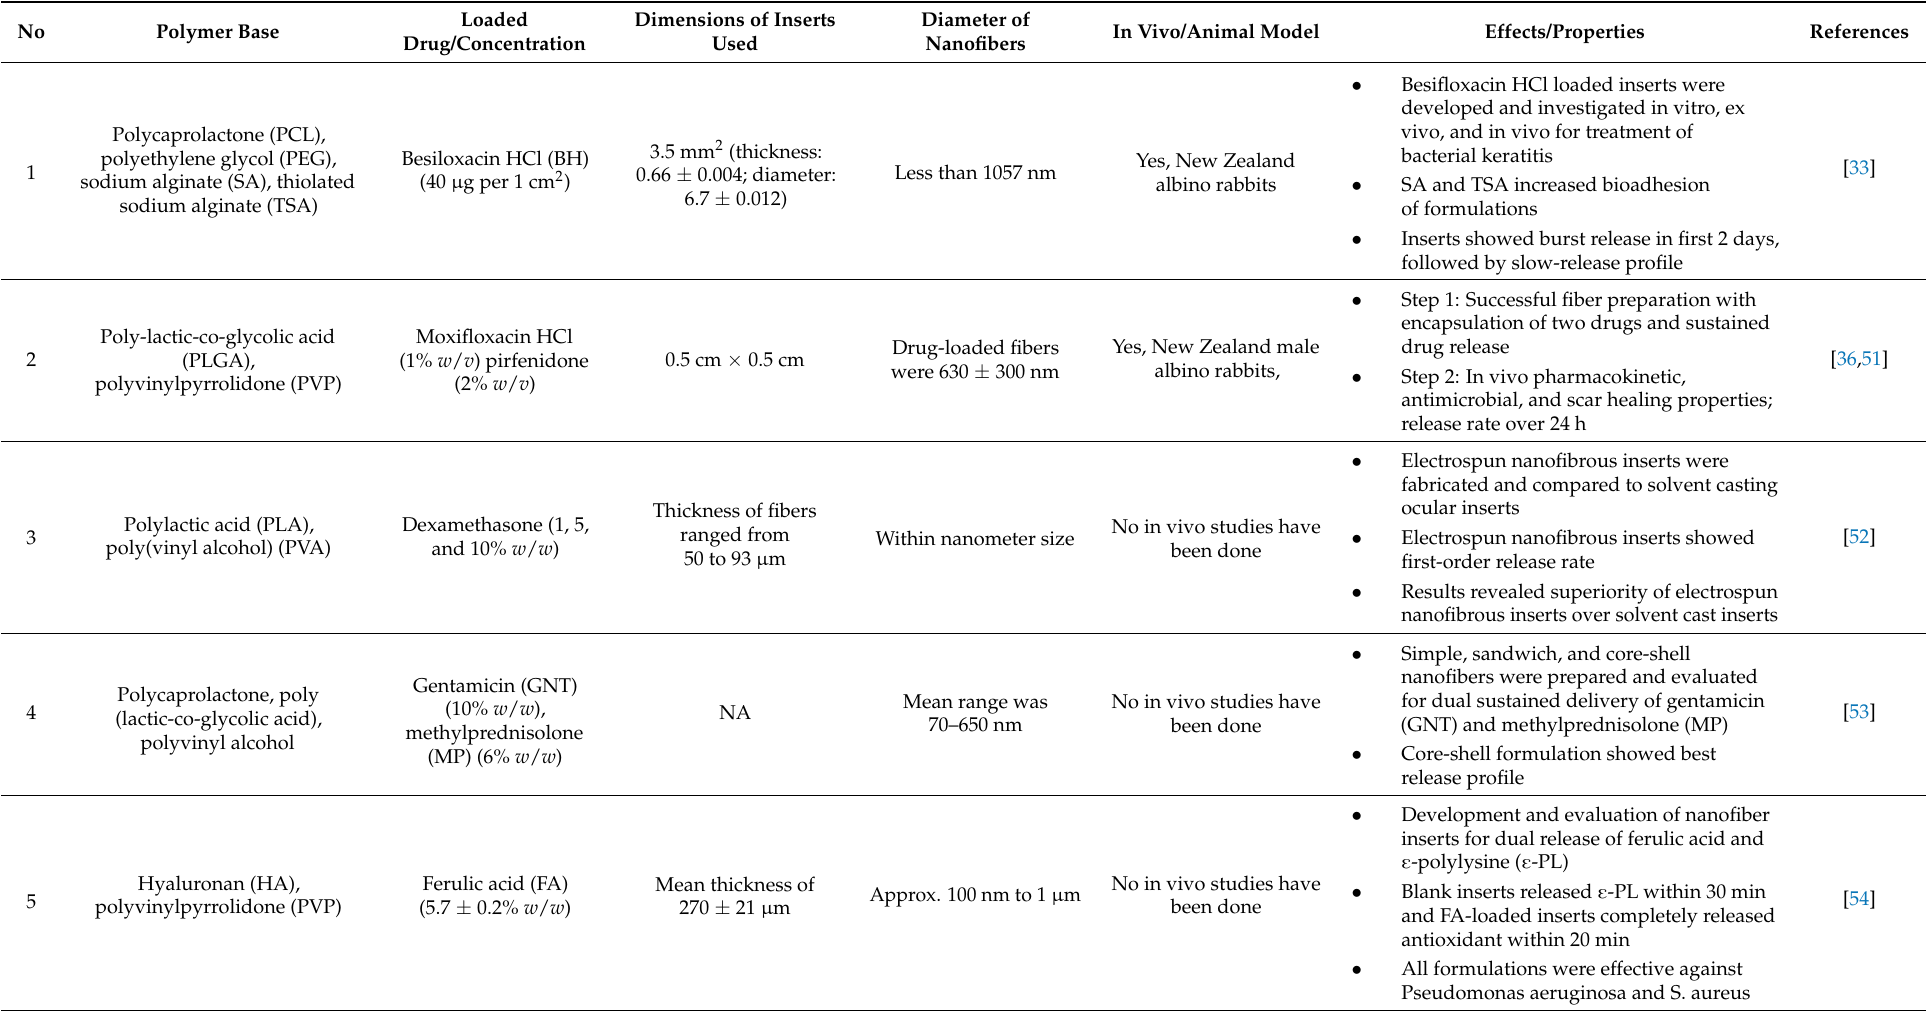
Table 1. Summary of nanofiber-based ocular insert